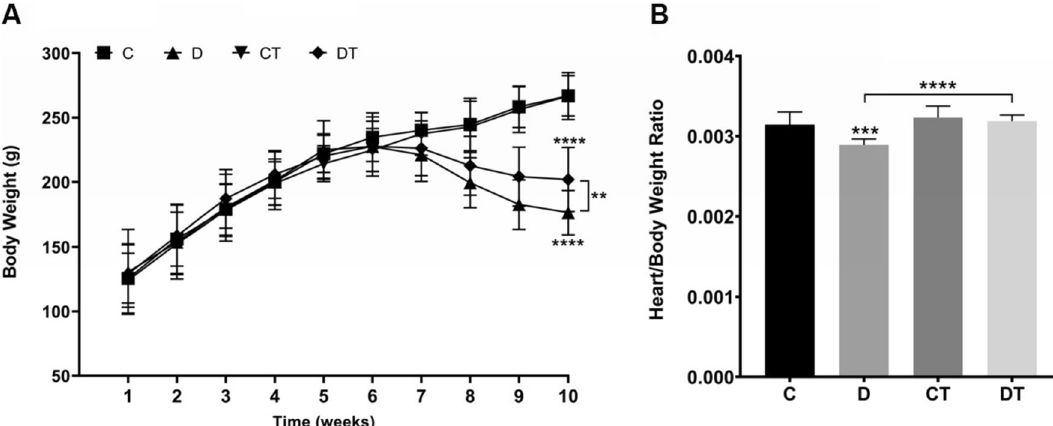
Figure 1. Preventive physical training improves functional capacity and attenuates doxorubicin-induced general toxicity. ( A ) Body weight (g); ( B ) Heart weight/body weight ratio. C: control (n = 10); D: doxorubicin- treated (n = 10); CT: control-trained (n = 10); DT: doxorubicin-trained (n = 10). One or Two-way ANOVA and Tukey’s post-hoc. **p < 0.01, ***p < 0.001, ****p < 0.0001 above error bars in comparison to control